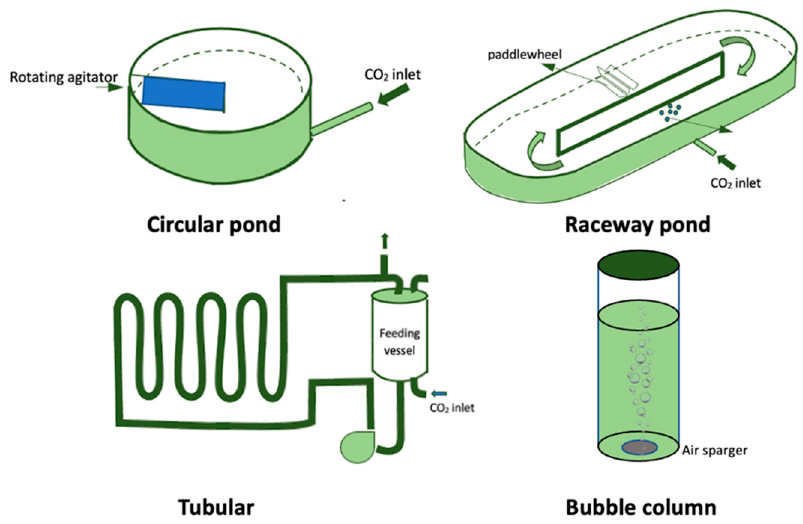
Figure 3. Different configurations of microalgae photoreactor system.